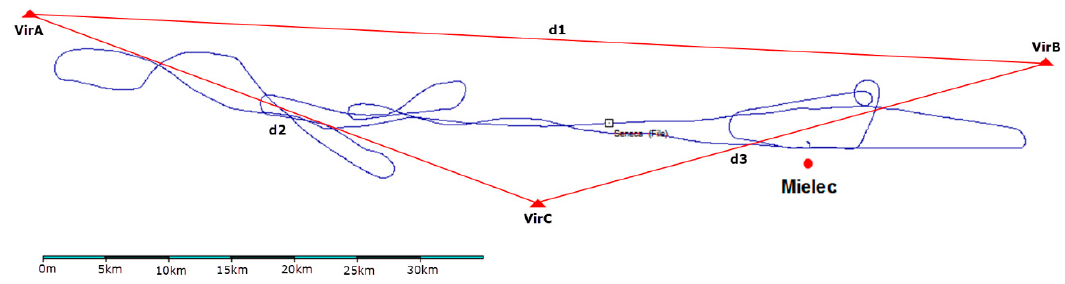
Figure 1. The horizontal trajectory of Seneca Piper PA34-200T aircraft with localisation of GNSS base stations.